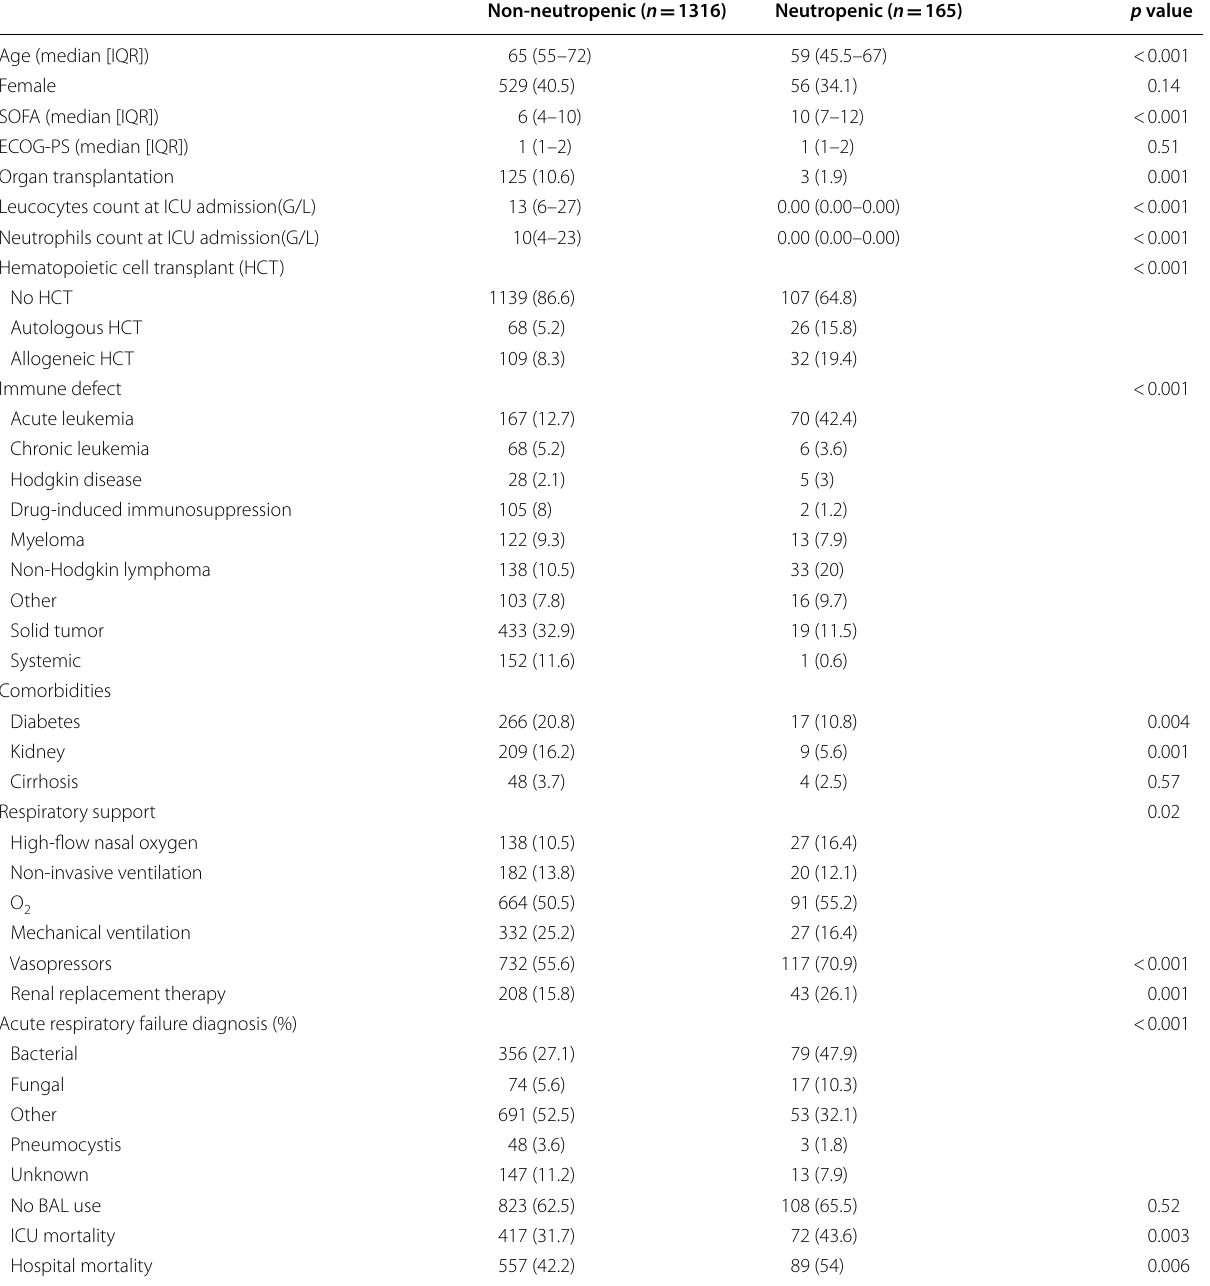
Table 1 Characteristics of neutropenic vs non-neutropenic